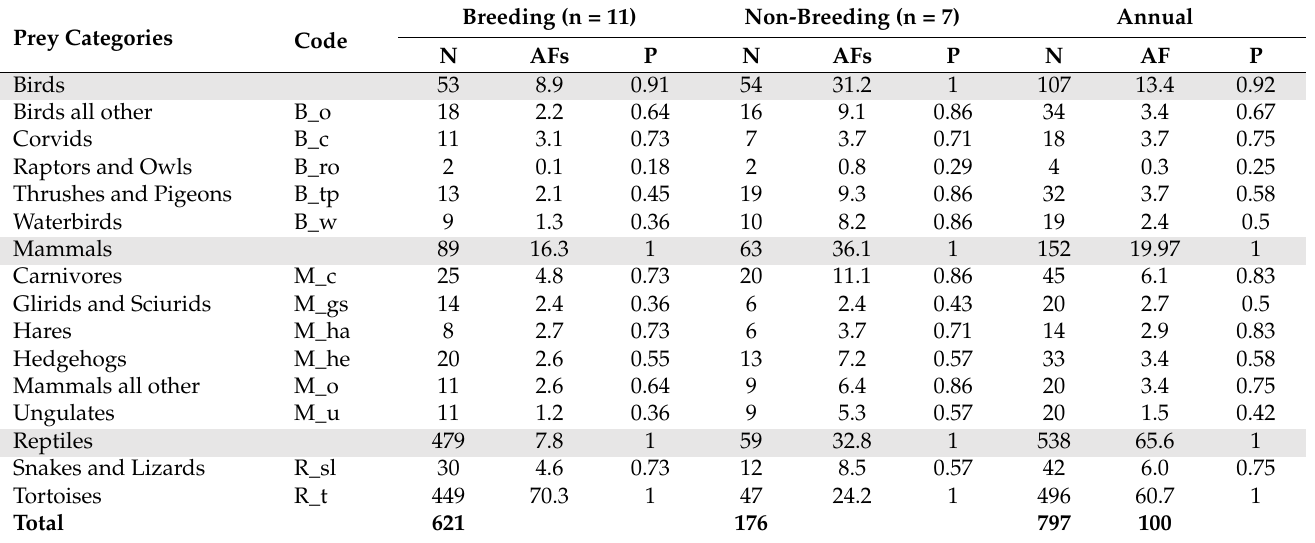
Table 1. Seasonal and annual diet of the golden eagle in northern Greece in terms of number of prey items per category (N), average seasonal (AFs) and average annual (AF) frequency of prey category across territories, as well as prey category prevalence (P) across